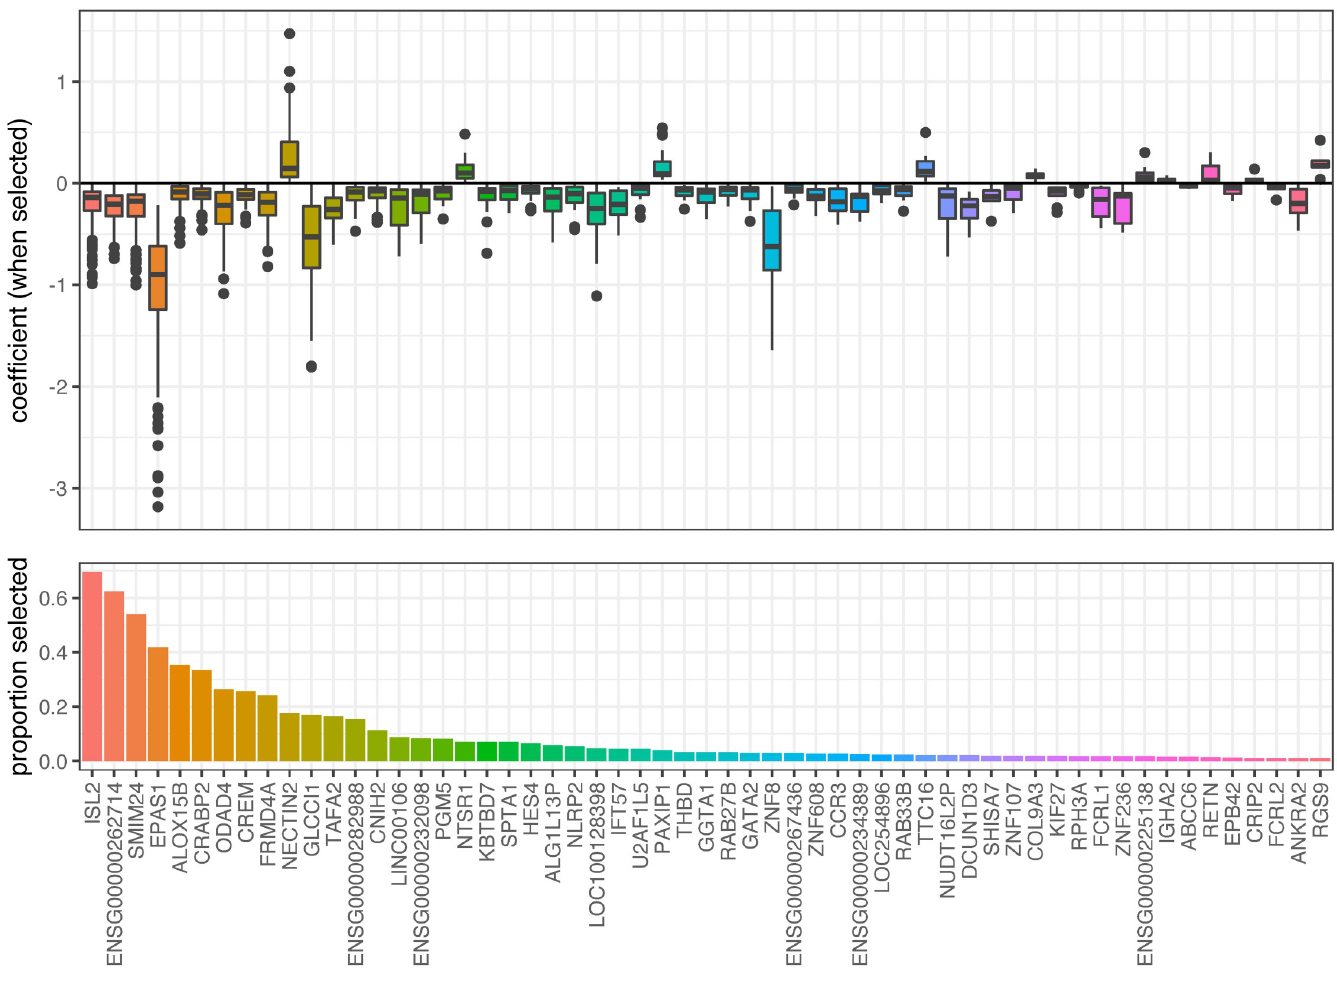
Fig 5. Association analysis for the transplant outcome of clinical CMV (CMV PCR > 137 IU/mL) and transcriptomic expression. Boxplots in the upper panel represent the coefficient value of each transcript when selected, and bar plots in the lower panel indicate transcription selection proportion. The transcripts shown are those selected in 1% or more of all training models. Transcripts are labeled with their gene symbol when available or their Ensembl ID. There were no clear trends in coefficient values as the selection proportion